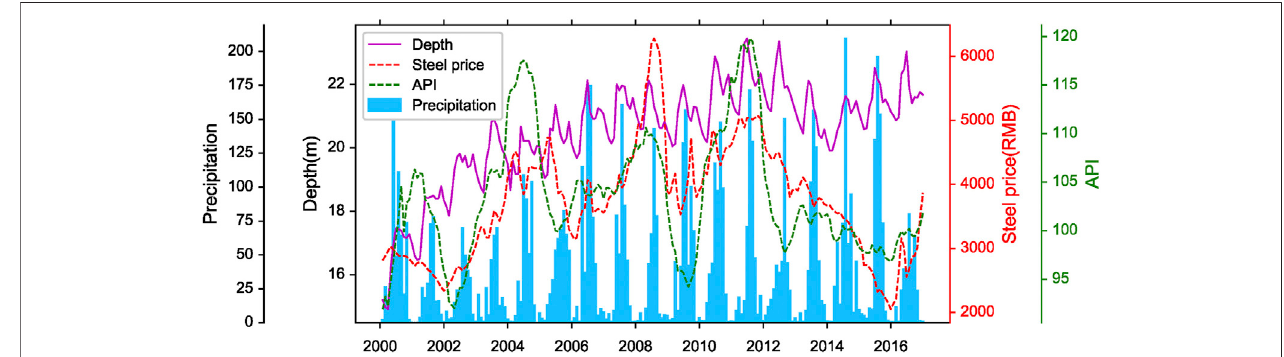
FIGURE 2 | Comparison of the average water table depth and precipitation, steel price and API.